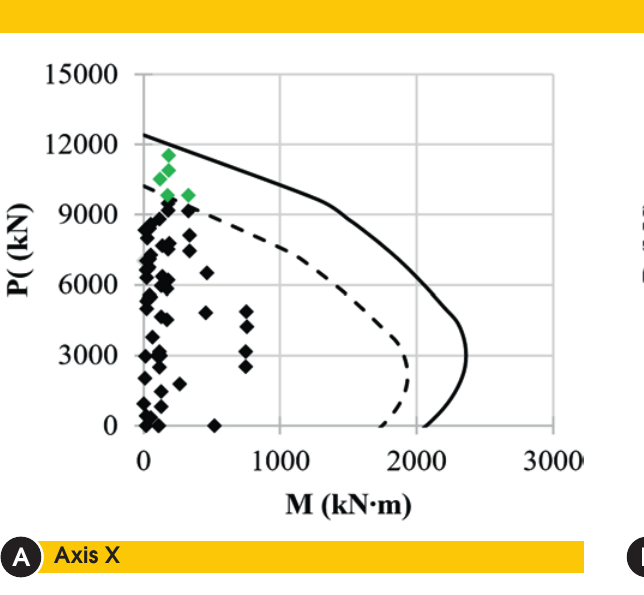
Figure 18 – Interaction diagrams for column P11 of 30